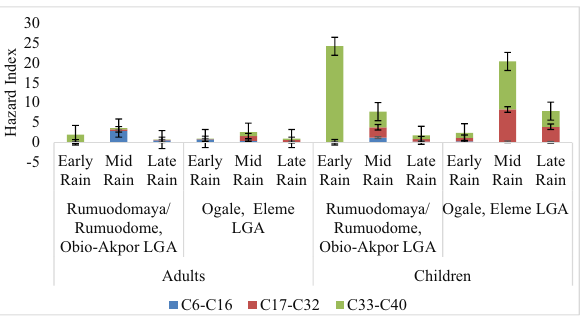
Figure 3. Hazard index of adults and children for aromatic petroleum